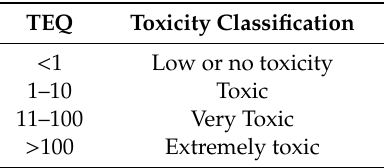
Table 2. Veith and Konasewich index.